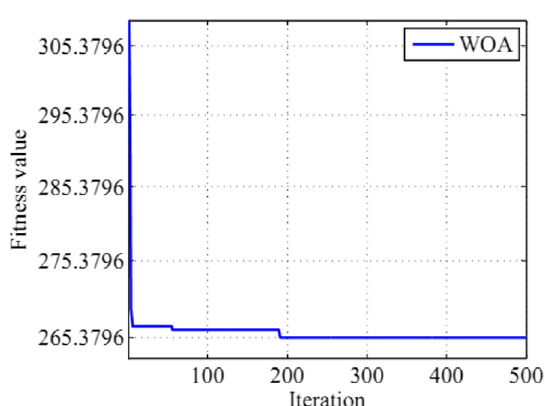
Fig. 10 Convergence characteristic of WOA in the case of IEEE 14-bus